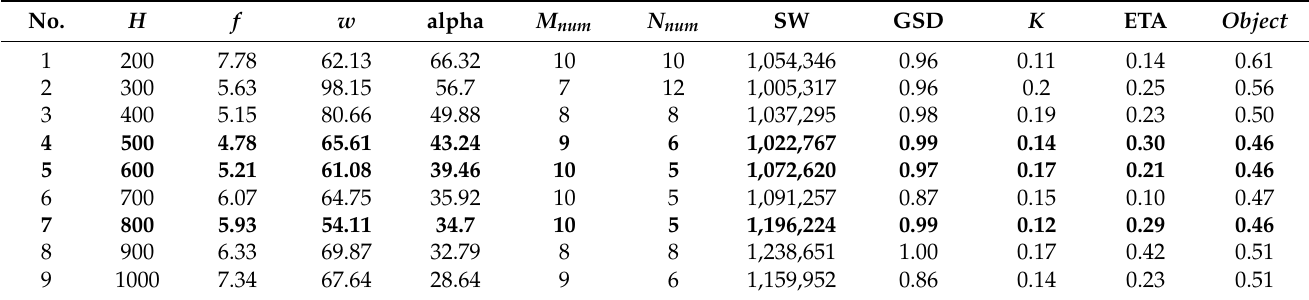
Table 1. Design results of system parameters at a typical low orbital